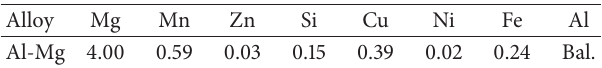
Table 1: Chemical compositions of the Al-Mg alloy in weight percent.